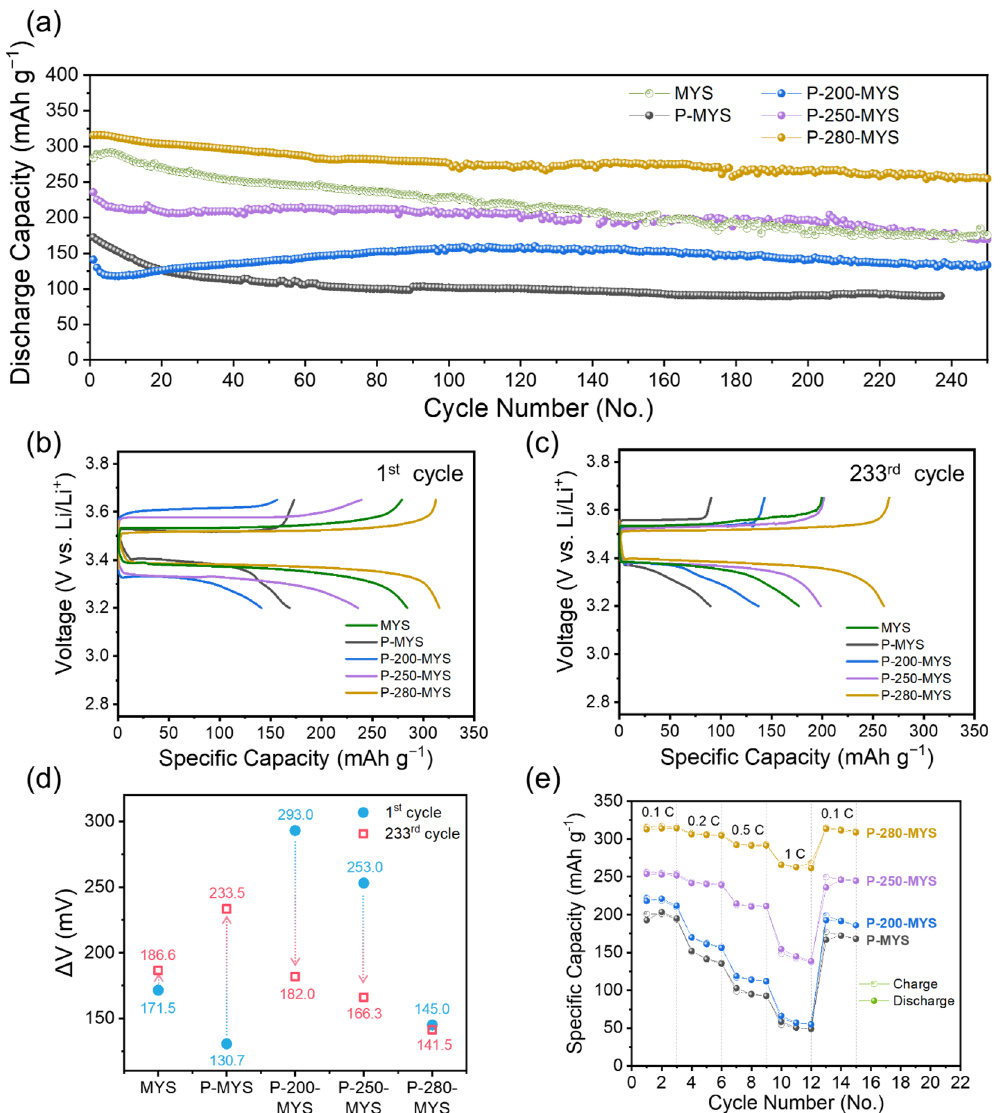
Fig. 4 Electrochemical performance of cathodes. a Cyclic performance. Galvanostatic voltage profiles at the b 1st and c 233rd cycles of the multi‑yolk–shell (MYS)‑CuO cathodes without PAN (MYS), with non‑cyclized PAN (P‑MYS), and with PAN cyclized at 200, 250, and 280 °C (P‑200‑MYS, P‑250‑MYS, and P‑280‑MYS, respectively) at 0.2 C. d Potential differences calculated at a depth of discharge of 50% and state of charge of 50% using the galvanostatic voltage profiles in b and c . e Rate capability of the cathodes at 0.1, 0.2, 0.5, and 1 C (1 C